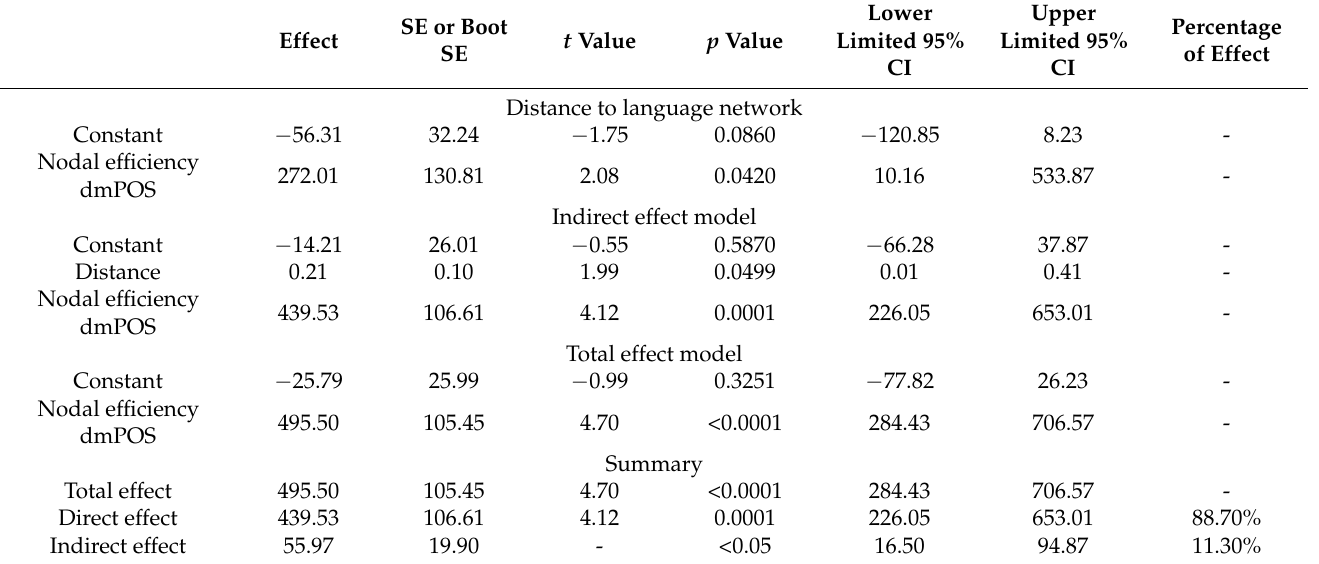
Table 5. Testing the mediation effect of nodal efficiency of dmPOS in the healthy hemisphere on language